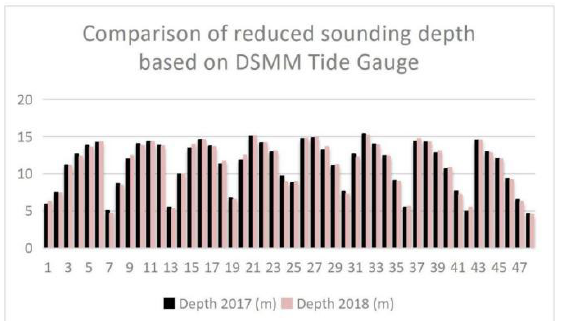
Figure 26. The comparison between depth observed in 2017 and 2018 relative to the DSMM tide gauge